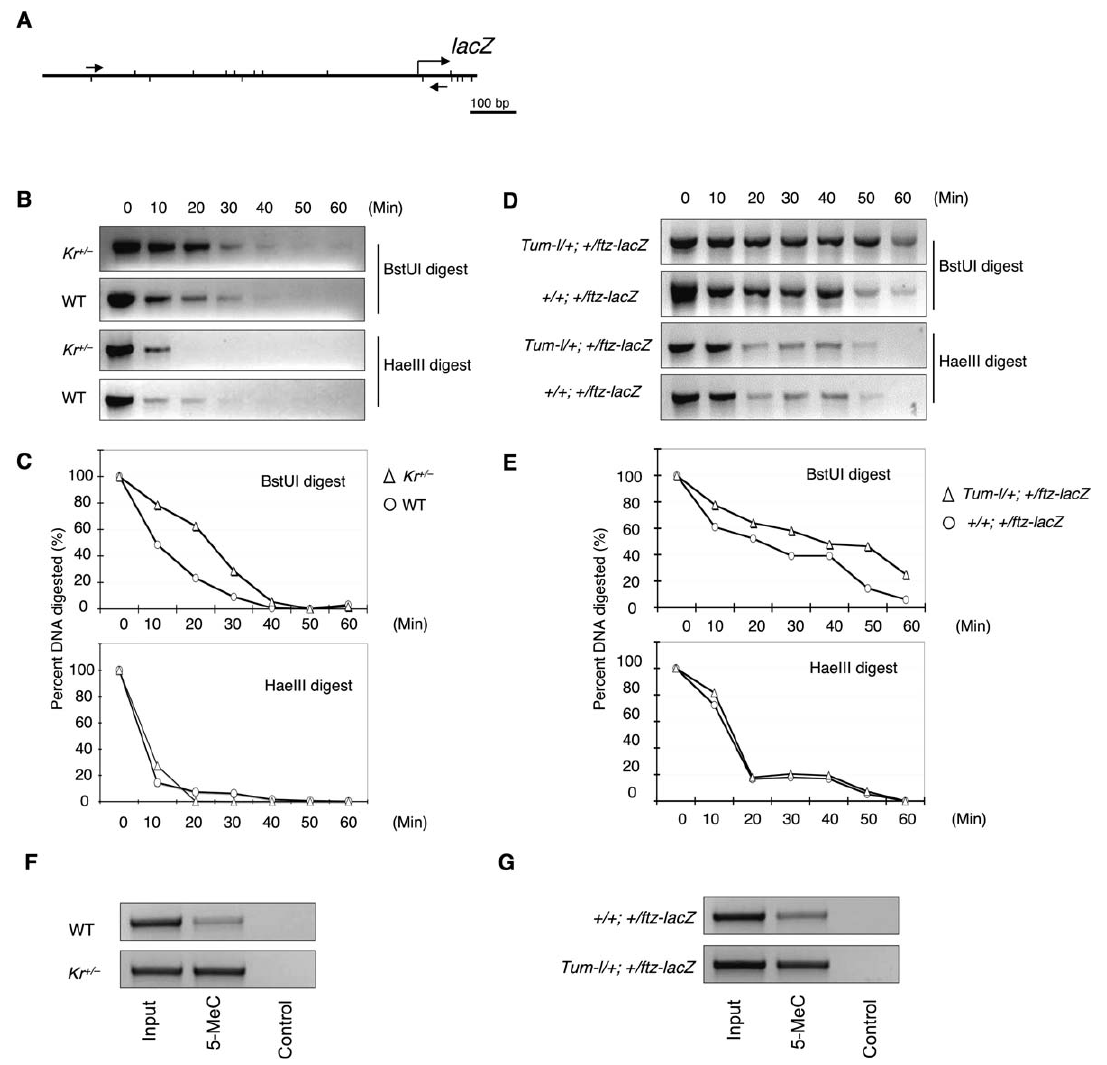
Figure 3. Increased Methylation of ftz Regulatory Region in Kr þ / (cid:2) Animals and Its Inheritance (A) Schematic representation of the ftz-lacZ reporter, showing the minimal ftz 5 9 regulatory region previously shown to be sufficient to drive expression of a ftz-lacZ reporter transgene in ftz patterns [30]. Arrows above and below the horizontal line represent PCR primers used to amplify a 778-bp fragment, encompassing the 620-bp minimal ftz enhancer (see Figure S2 for sequence). Bent arrow indicates the start of the lacZ sequence. Vertical bars above and below the line represent positions of recognition sequences for restriction enzymes BstUI (CGCG) and HaeIII (GGCC), respectively. (B–E) Time courses of restriction digests of genomic DNA with enzymes sensitive (BstUI) or insensitive (HaeIII) to methylated DNA are shown as agarose gel pictures and quantifications. Genomic DNA was isolated from Kr 1 /CyO ftz-lacZ and þ /CyO ftz-lacZ (wild-type control) adult flies (B, C), or from the F1 progeny flies of Kr 1 /CyO ftz-lacZ males crossed to hop Tum-l/ þ females or wild-type females (D, E), and digested with the indicated enzymes for the indicated times (minutes). Digested DNA was amplified with PCR primers shown in (A) and run on an agarose gel. Note that the genomic DNA from Kr þ / (cid:2) flies or from the F1 progeny of hop Tum-l/ þ females and Kr 1 /CyO ftz-lacZ males is more resistant to BstUI digestion than the controls. (F, G) Digested genomic DNA purified from embryos was immunoprecipitated by antibodies to methylated cytosine and amplified by PCR primers shown in (A). Embryos derived from wild-type or Kr þ / (cid:2) parents (F), or from Kr 1 /ftz-lacZ males crossed to wild-type (top) or Tum-l/ þ (bottom) females (G) were used for DNA isolation. Note the presence of higher levels of 5-meC in the ftz-lacZ promoter in Kr þ / (cid:2) embryos or in those from Tum-l/ þ females crossed to Kr 1 /ftz-lacZ males.